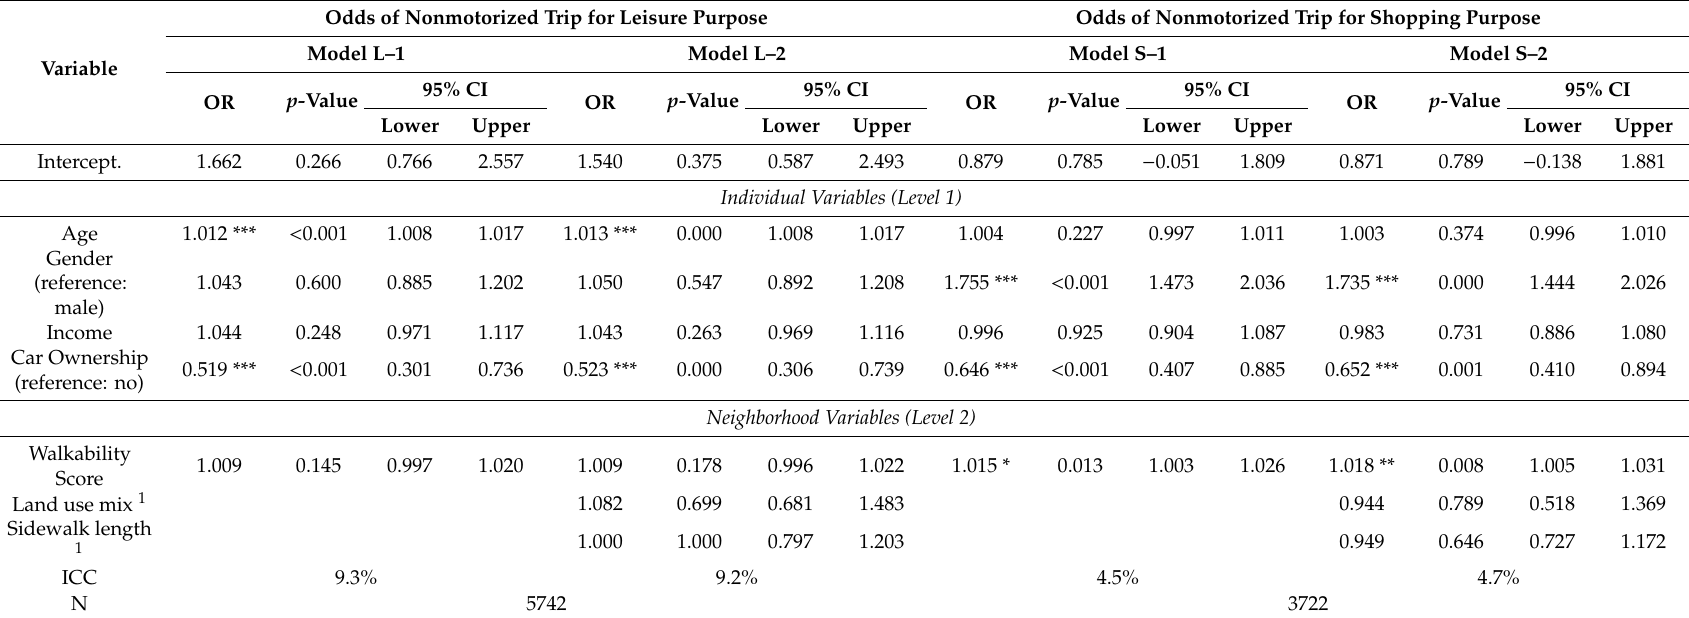
Table 3. Results of the multilevel logit regression analyses for estimating environmental correlates of active transportation in leisure and shopping purposes.